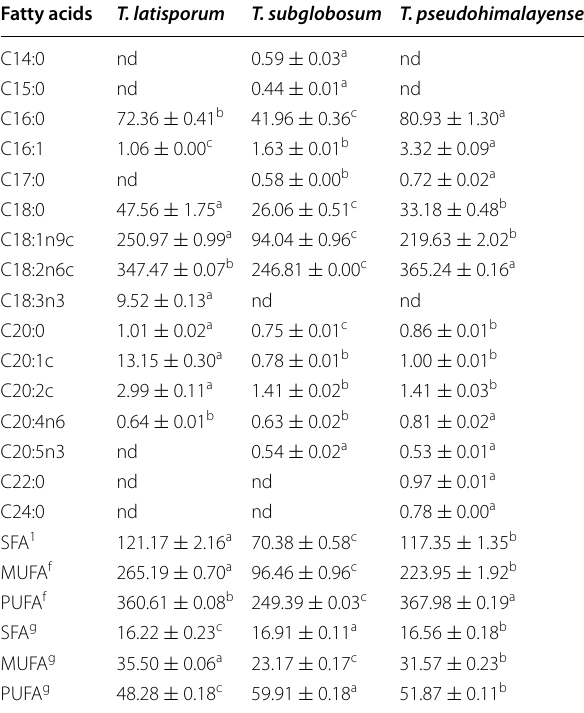
Table 2 Distribution of individual fatty acids (mg) in dried powder (100 g) formulations of three Tuber species